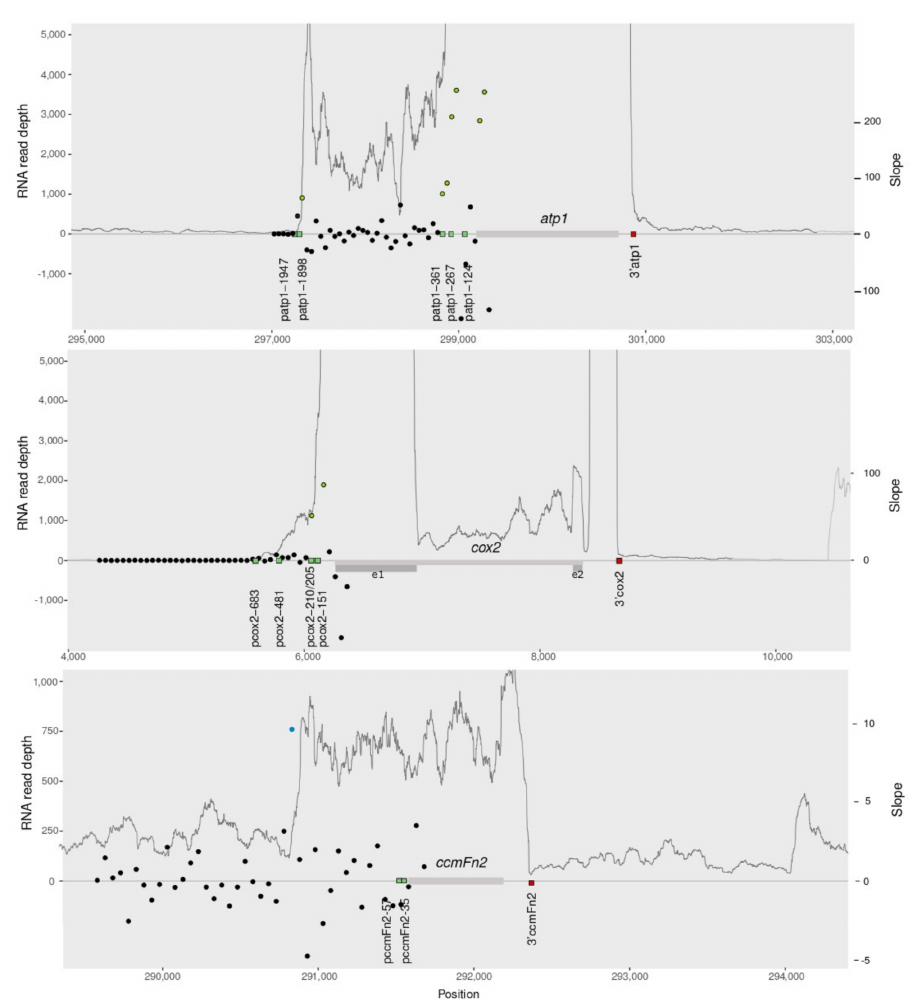
Figure 2. RNA read depth of three protein-coding genes and 2 kb flanking regions in the Arabidopsis mtDNA based on the combined data sets of the three biological samples. The slopes of the read depth (filled circles) were calculated every 50 bp in the 2 kb upstream of each gene. Gray bars represent genes and dark gray bars are exons. Green squares represent start of transcription and red squares represent 3 (cid:48) termini, identified experimentally [36,42,44]. The higher values of the slopes that fall within a 100 bp window around the transcription start sites identified experimentally are shown as green circles. The higher values of the slopes found upstream of the reported transcription start sites are shown as blue circles. Below each graph, the mtDNA coordinates of the strand in which the gene is located are